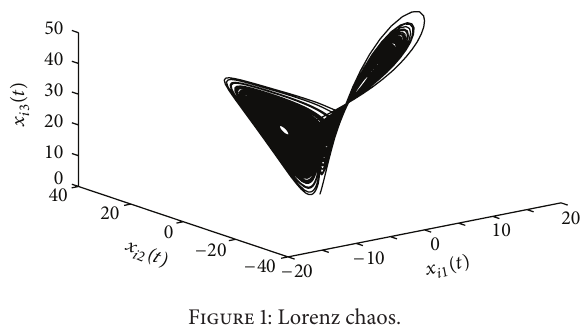
Figure 1: Lorenz chaos. The Lorenz system is symmetrical with respect to the 𝑥 𝑖3